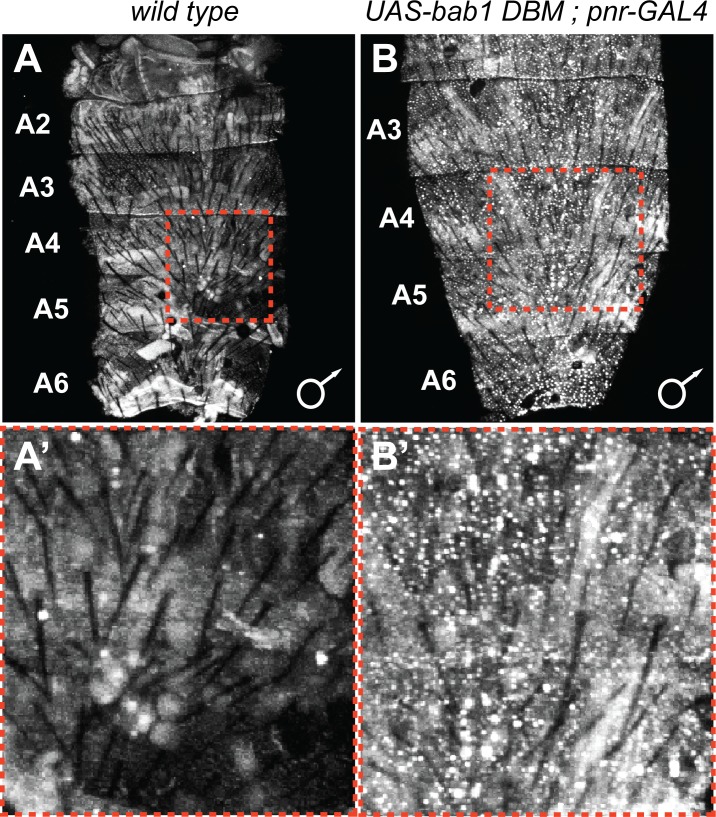
Ectopic expression of the Bab1-DNA-binding mutant protein.(A) Little-to-no endogenous Bab1 protein can be detected in the dorsal abdominal epidermis of D. melanogaster male pupa. (B) In contrast, nuclear-localized expression of the Bab1 DNA-binding mutant protein can be observed when the UAS-transgene was ectopically expressed under the control of the pnr-GAL4 driver. (A’ and B’) Zoomed in view of the expression within the regions outlined by dashed red boxes in panels A and B. Samples shown are at a pupal developmental stage of ~88 hr after puparium formation.